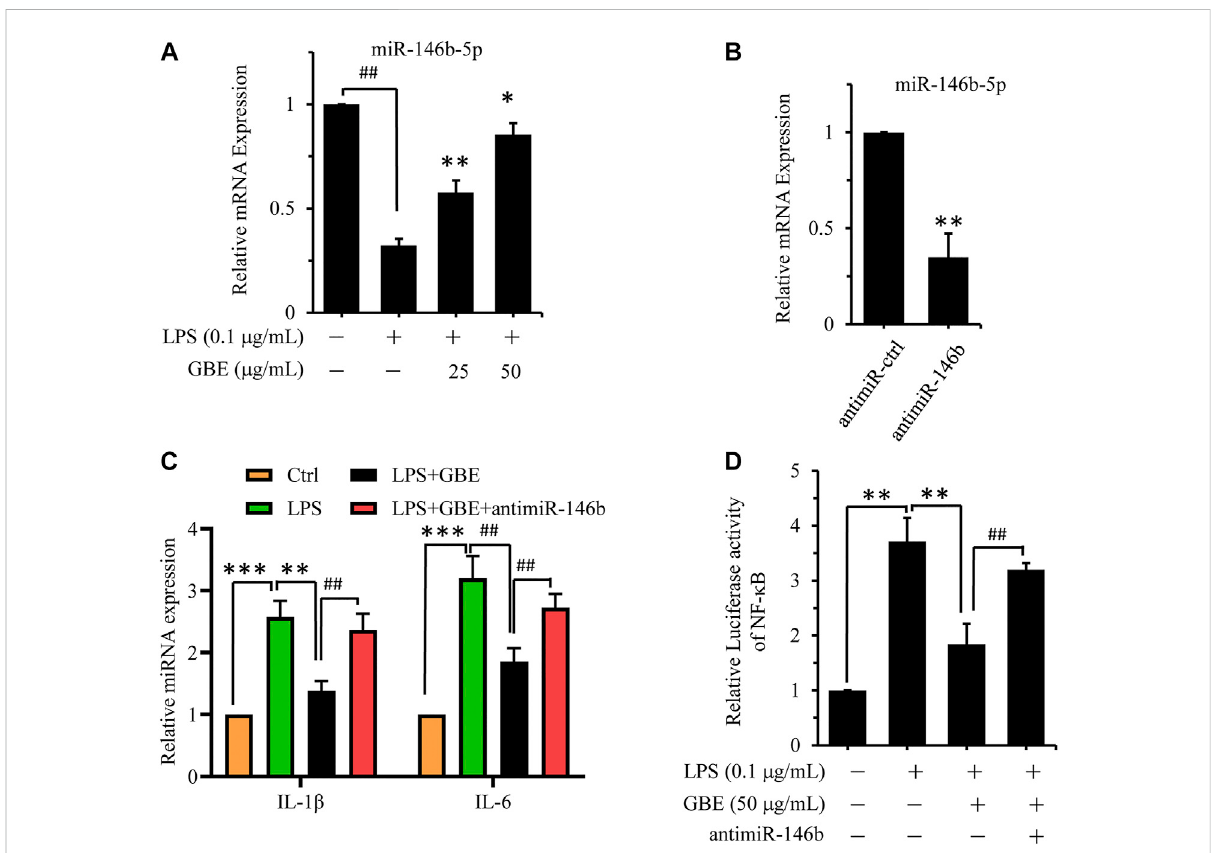
FIGURE 6 GBE suppressed neuroin fl ammation via upregulating miR-146b-5p expression. (A) U87 cells were pre-treated with GBE (25 and 50 µg/ml) for 1 h, and then incubated with or without LPS (0.1 µg/ml) for 24 h. The expression of miR-146b-5p was detected by qPCR (## p < 0.01 vs. vehicle control, * p < 0.05, ** p < 0.01 vs. LPS group). (B) U87 cells were transfected with miR-146b-5p inhibitor for 24 h, and then the expression of miR- 146b-5p was detected by qPCR (** p < 0.01 vs. inhibitor negative control (NC)). (C) U87 cells were transfected with miR-146b-5p inhibitors for 24 h, and then pre-treated with GBE (50 µg/ml) for 1 h, followed by incubation with or without LPS (0.1 µg/ml) for 24 h. The expression of IL-6 and IL-1 β were measured using qPCR (** p < 0.01 vs. LPS group; ## p < 0.001 vs. GBE group). (D) 293T cells were cotransfected with pNF κ B-luc, renilla luciferase reporter, and miR-146b-5p inhibitors for 24 h; thereafter, cells were pre-treated with GBE (50 µg/ml) for 1 h, followed by incubation with orwithoutLPS(0.1 µg/ml)for24 h.Luciferaseactivitywasdeterminedusingadual-luciferasereporterassaysystem(** p < 0.01vs.LPSgroup;## p < 0.001 vs. GBE